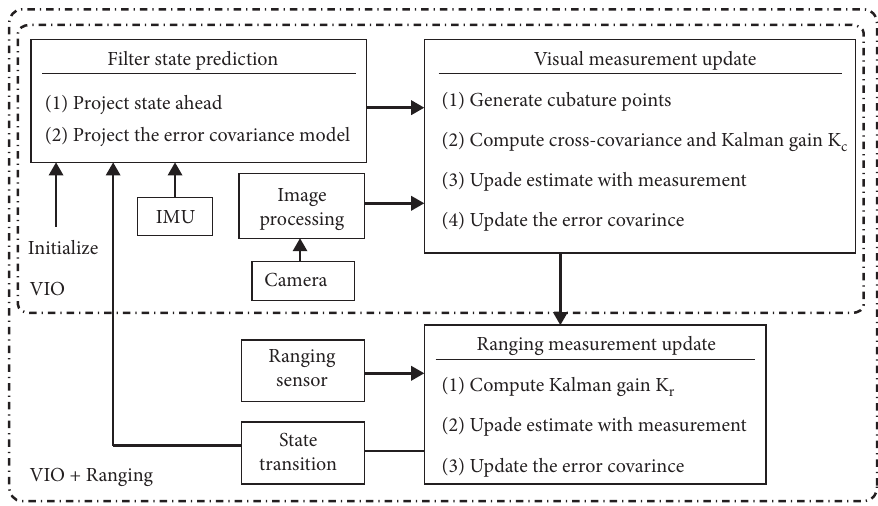
Figure 14: System architecture for integrating pseudorange